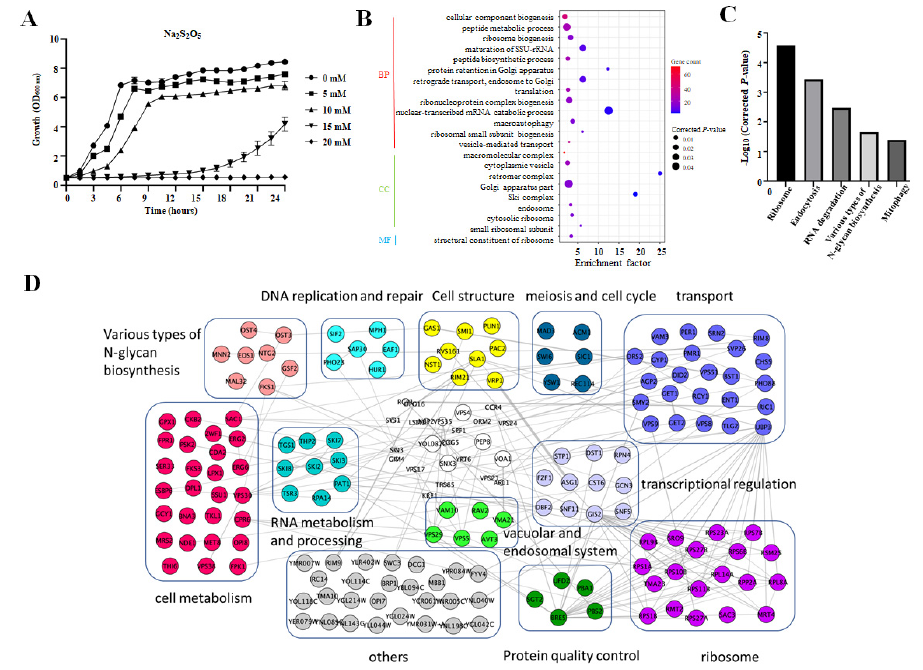
Figure 1. Identification of Na 2 S 2 O 5 -sensitive mutants by genome-wide screen. ( A ) Growth curve of BY4741 in YPD medium with different concentrations of Na 2 S 2 O 5 . ( B ) GO term analysis for the 162 genes for which deletion results in Na 2 S 2 O 5 sensitivity. BP, biological process; CC, cellular component; MF, molecular function. ( C ) KEGG analysis for the 162 genes for which deletion results in Na 2 S 2 O 5 sensitivity. ( D ) Physical interactions of the 162 Na 2 S 2 O 5 -sensitive genes. These genes were classified into 12 groups. The node colors indicate different functions. Genes in the white group were not in our list.